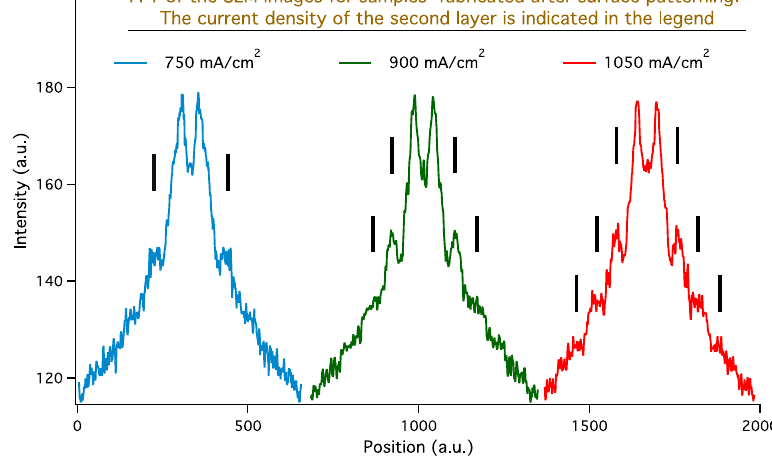
Figure 7. FFT profiles obtained from the FFT images in the bottom row of Figure 6. The profiles are obtained from the yellow rectangles, as described in Figure 5 caption. The order of the curves reproduces the order of the SEM images. The green and red curves have been translated along the x-axis for readability, while the blue curve is on its original position. The formation current density, with all other parameters kept identical, has been progressively increased going from the blue to the red curve. The presence of peaks, related to the pore distribution ordering, is indicated with small black vertical bars for each curve.